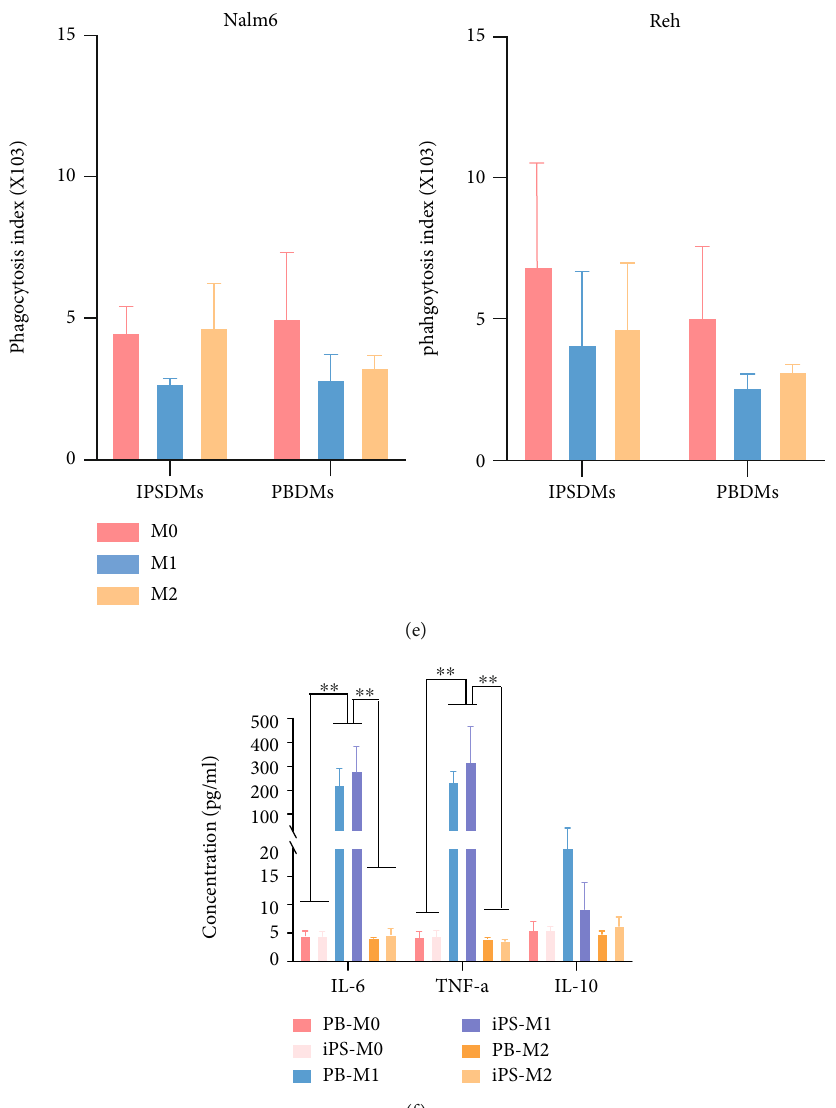
Figure 4: Identi fi cation of the di ff erent polarized subtypes from IPSDM. (a) Representative bright- fi led images of M0 (left panel), M1 (middle panel), and M2 cells (right panel) from hiPSCs. Scale bars, 100 μ m. (b) Flow cytometric analysis of markers CD45, CD14, CD11b, CD80 (M1), CD86 (M1), CD163 (M2), and CD206 (M2) of IPSDMs and PBDMs. (c, d) Flow cytometric analysis of the uptake of fl uorescent beads by subtypes of IPSDMs and PBDMs. All experiments were performed three times. Error bars, SD. (e) Flow cytometric analysis of phagocytosis of IPSDM and PBDM subtypes on Nalm6 (labeled with Hoechst 33342) and Reh (labeled with Hoechst 33342) ( IPSDMs : tumorcells = 1 : 4 ). Phagocytosis index: the percentage of V450 + macrophages multiplied by the MFI of V450. Error bars, SD. (f) Concentration of IL-6, IL-10, and TNF- α in the supernatants of M0, M1, and M2 cells after 48-hour polarization. ∗∗ P < 0 : 01